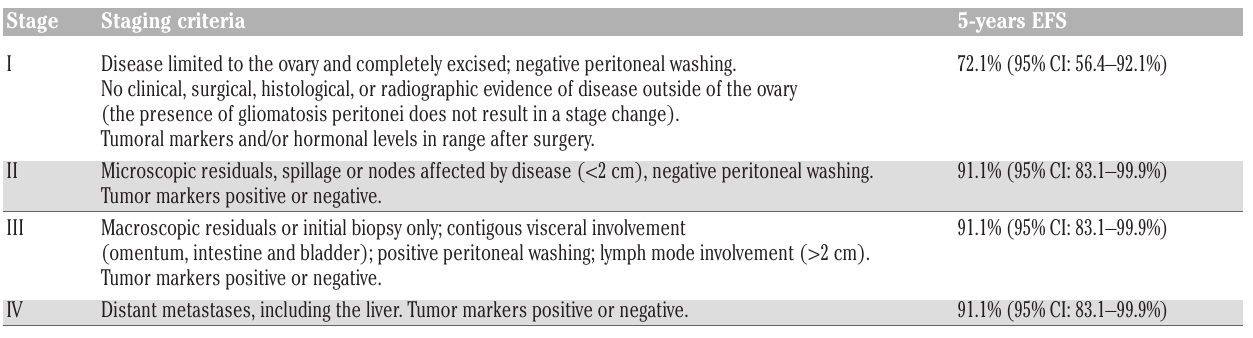
Table 3. Ovarian germ cell tumor staging (modified according to the Children's Oncology Group staging) and event free survival (EFS). 35,36 Stage Staging